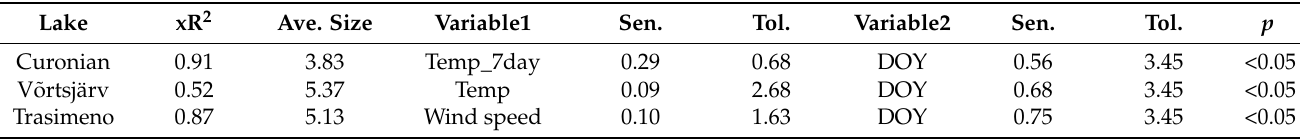
Table 3. Results of NPMR (Nonparametric Multiplicative Regression) models for chlorophyll-a. xR 2 = cross-validated R 2 ; Ave. size = Average neighborhood size; Tol. = Tolerance; Sen. = Sensitivity; Temp_7day = 7-day antecedent average air temperature; Temp = Daily air temperature; DOY = Day of